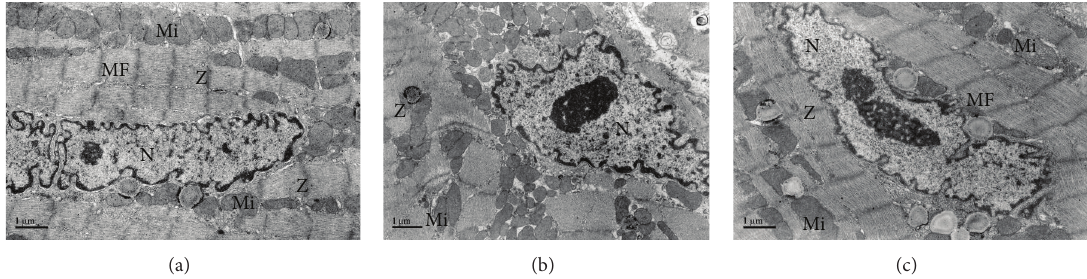
Figure 4: Electron microscopic examination of nuclei, mitochondria, sarcomeres, and myofibrils in the LV myocardium after 10 weeks: (a) control group, (b) DM group, and (c) DMT group. N: nuclei; Mi: mitochondria; Z: sarcomere; MF: myofibrils.